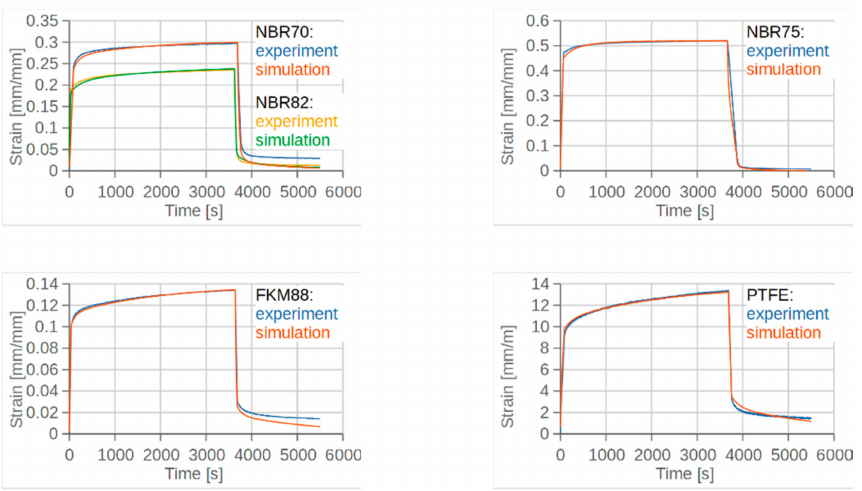
Figure 5. Comparison of constant stress test results versus constant stress FEM simulation for each seal material modeled with the Prony shear relaxation material